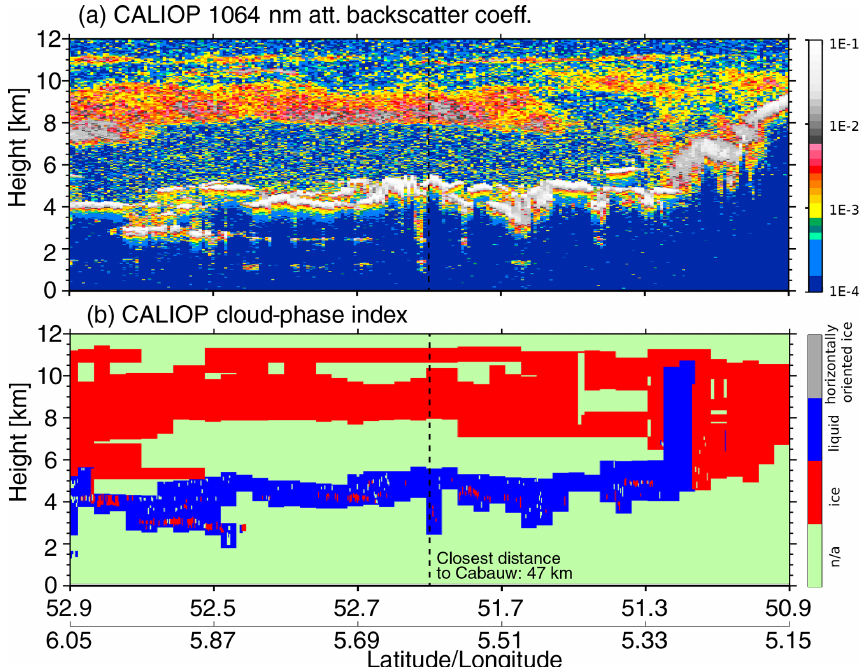
Figure 6. (a) Curtain plots of CALIOP 1064nm attenuated backscatter coefficient and (b) CALIOP cloud-phase index on 5 October 2014 where the closest distance of CALIPSO to Cabauw was 47km at